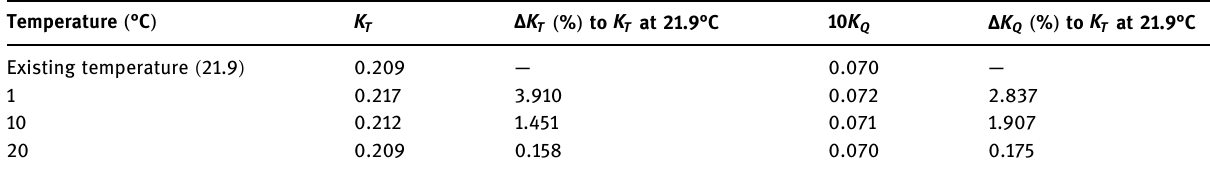
Table 9: Comparison of coe ffi cient of thrust and torque for case 2 J σ 1.269,